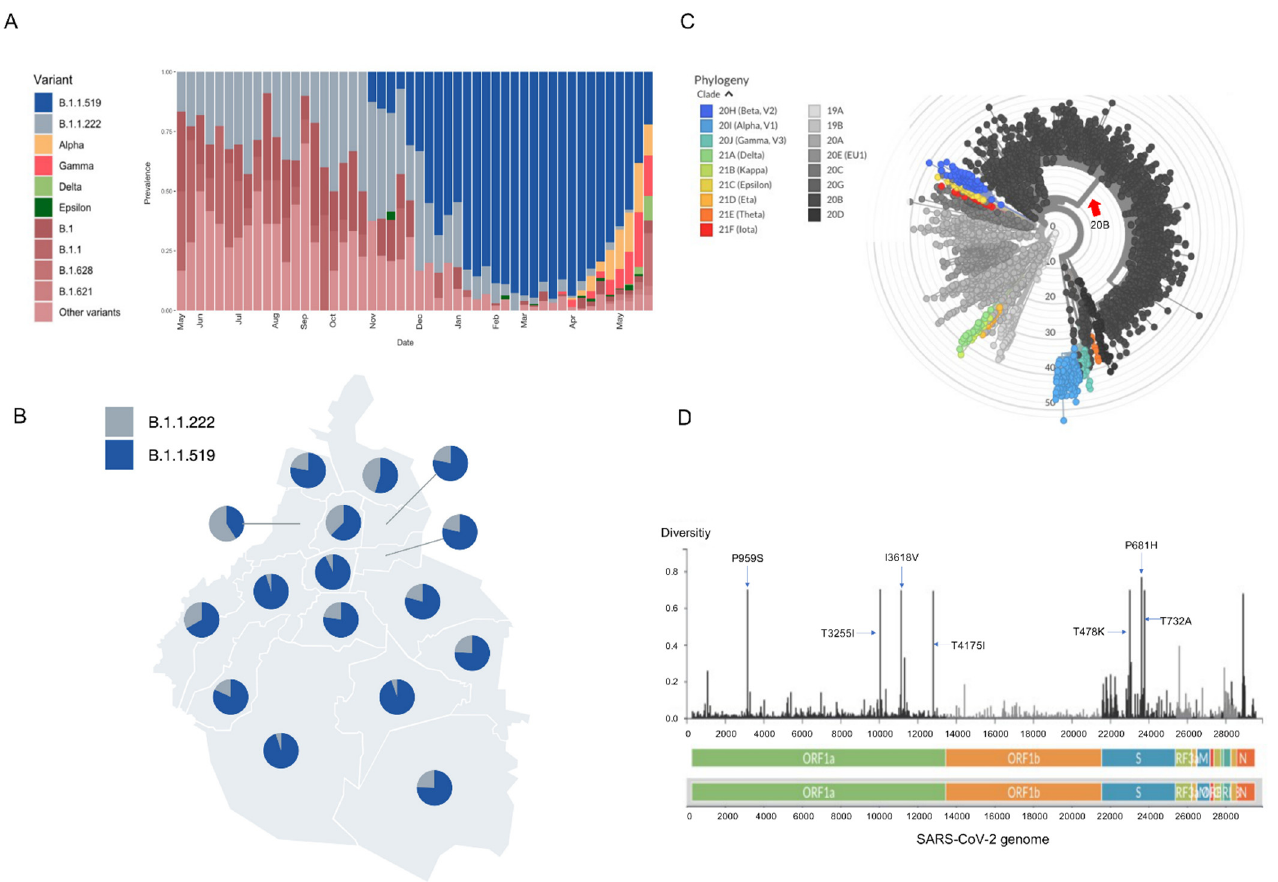
Figure 1. ( A ) Frequencies of the B.1.1.519 variant in Mexico City from May 2020 to May 2021. ( B ) The geographic distribution of B.1.1.519 and B.1.1.222 variants in Mexico City, with dominance of the first variant. ( C ) Phylogenetic tree of SARS-CoV-2 with NextClade clades. The branch indicated with a red arrow represents 1879 sequences of the B.1.1.519 variant of Mexico City with coverage of >99.5%. ( D ) Genome map of SARS-CoV-2 variant B.1.1.519 with the most representative amino acid substitutions in 1879 sequences of the B.1.1.519 variant of Mexico City with coverage of >99.5%.